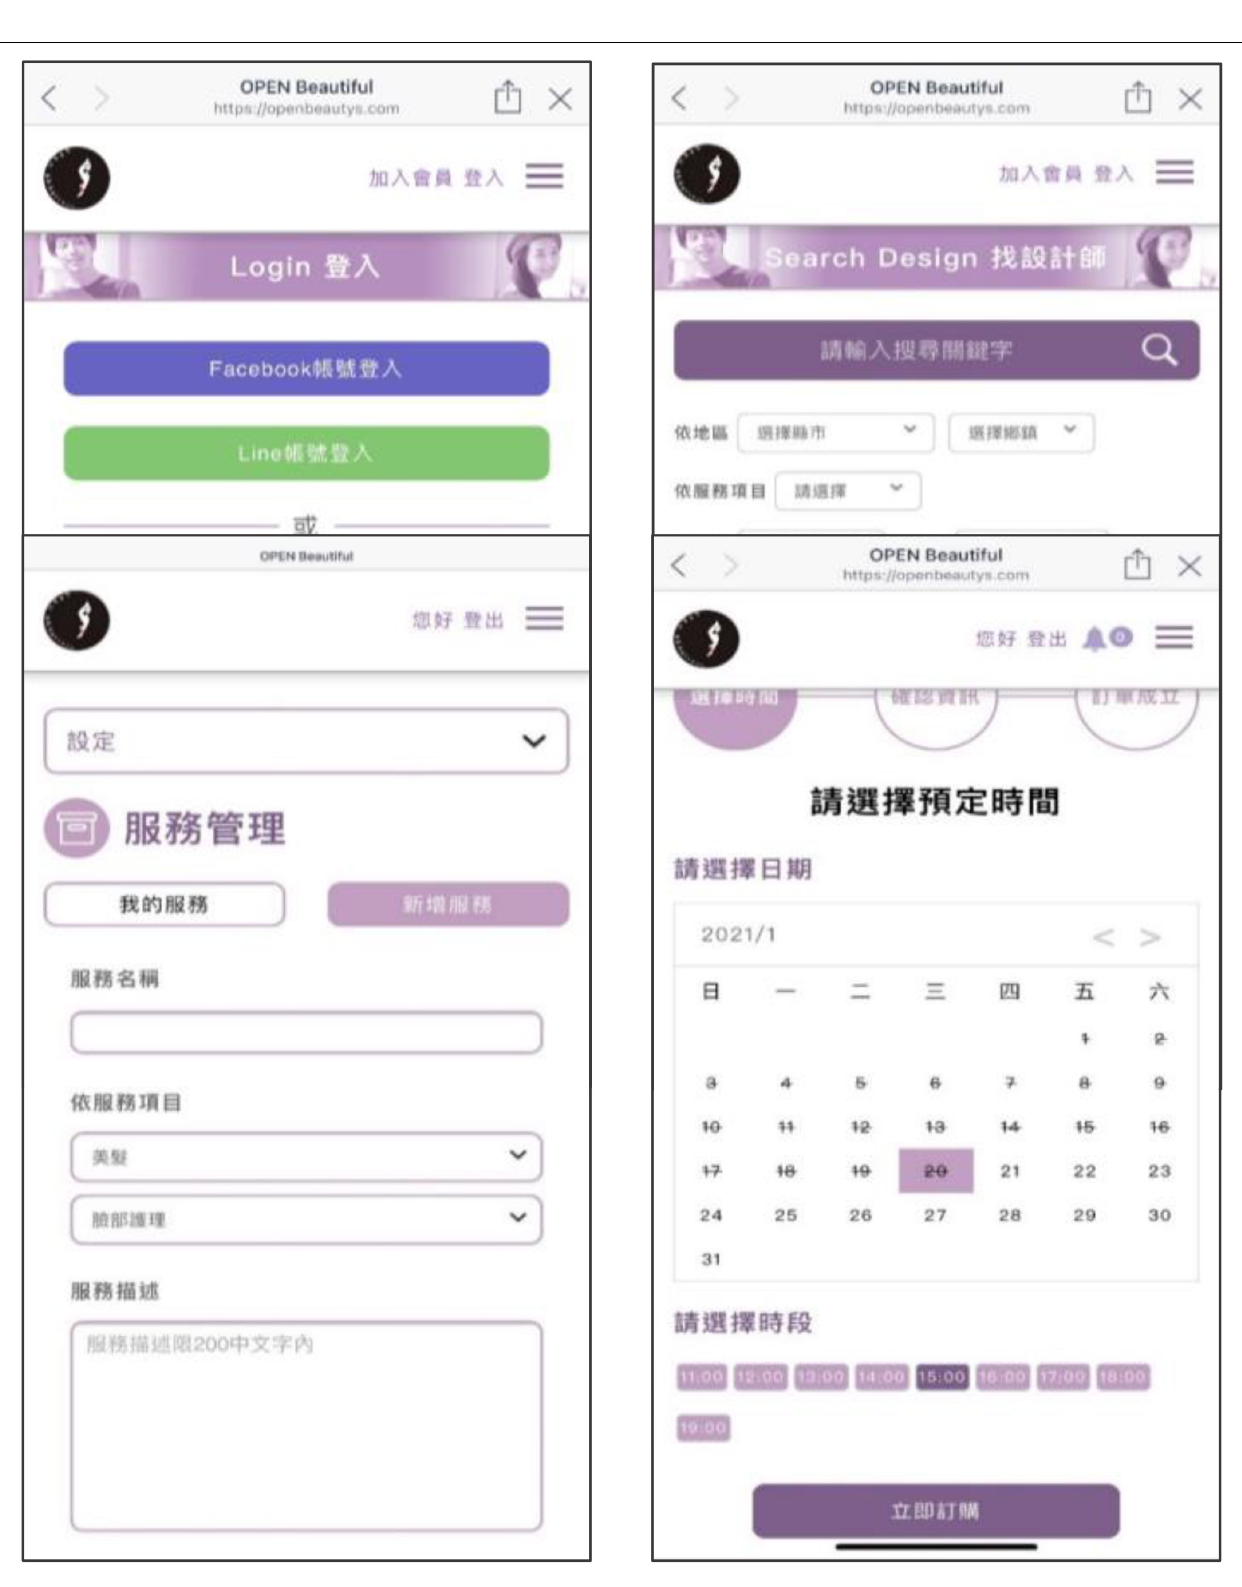
FIGURE 4 | OpenBeautiful app user